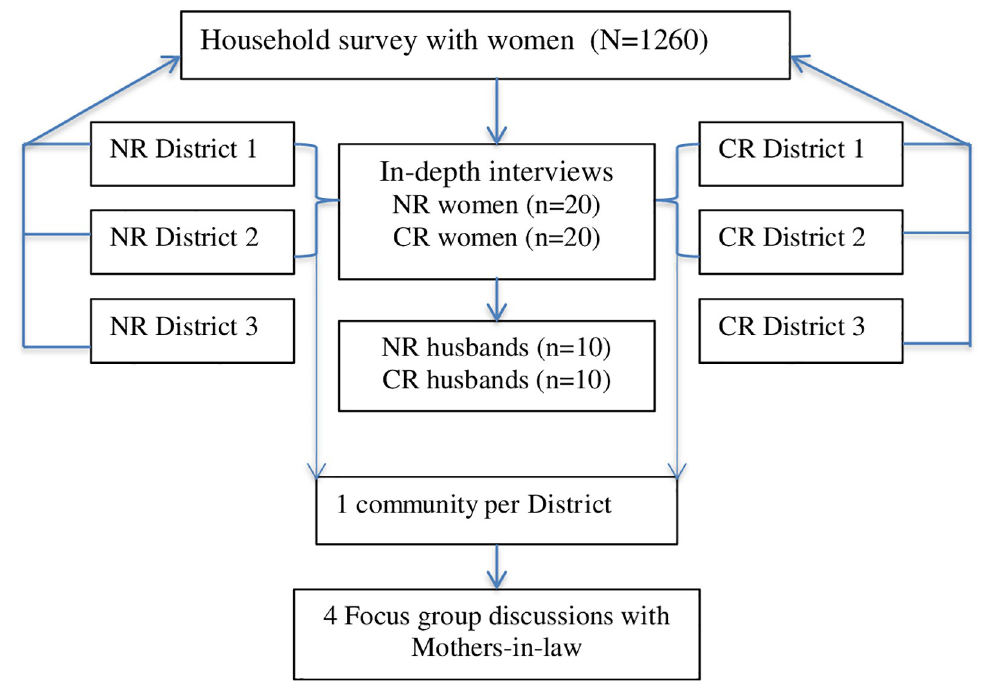
Fig 1. Study design and sample